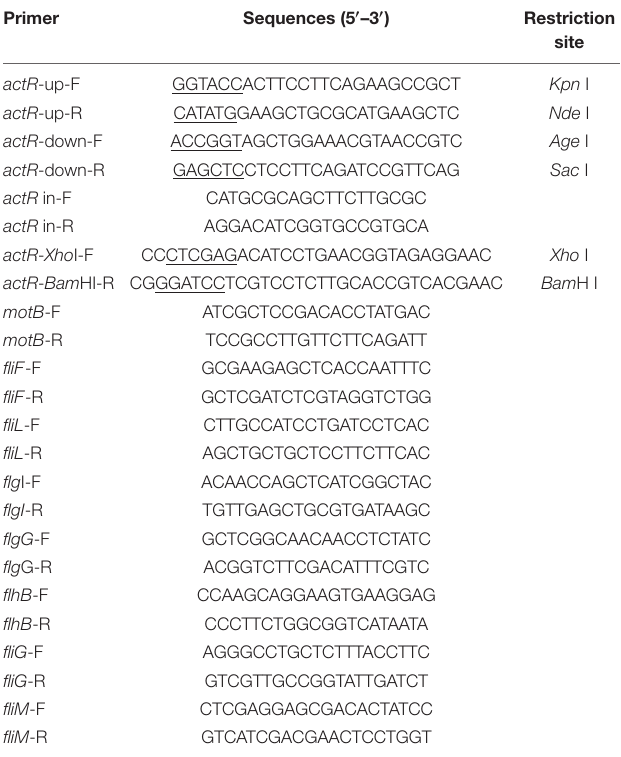
TABLE 2 | Primers used in this study. Primer Sequences (5 (cid:48) –3 (cid:48) ) Restriction